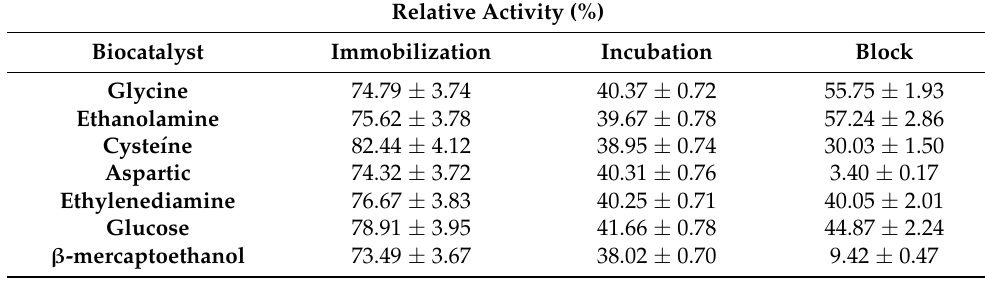
Table 4. Effect of the blocking agent on the expressed activity of PGA immobilized on VS-agarose. The enzyme was immobilized in 1 M sodium sulfate/50 mM sodium phosphate pH 7.0, incubated in sodium carbonate 50 mM (100 mM phenylacetic acid and 30% glycerol) at pH 10.0 for 3 h. The concentration of the blocking agents was 2 M at pH 8.0 for 48 h. The experiments were conducted as described in the Methods.